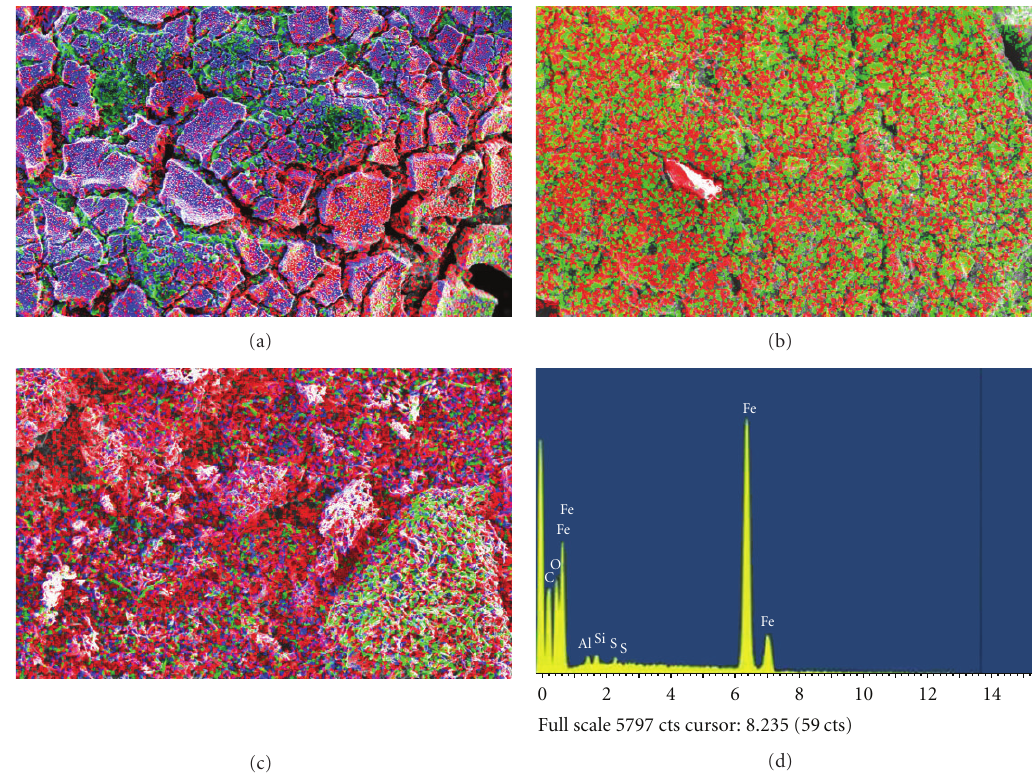
Figure 2: X-ray mapping images of (a) MN-5 (red-Fe, green-C, and blue-O), (b) MN-6 (blue-Fe, green-O, and red-C), (c) MN-7 (green-Fe, red-O, and blue-C), and (d) EDS spectrum of MN-7.